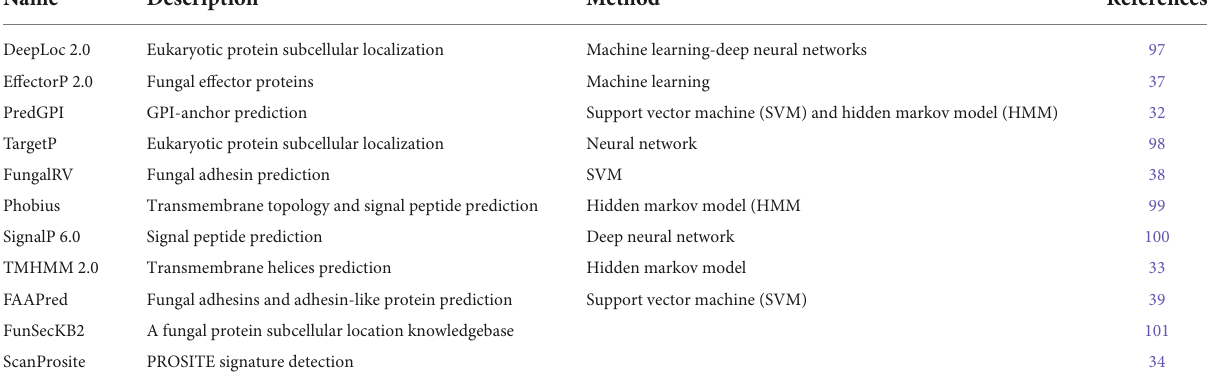
TABLE 1 Web-servers and databases used for sequence